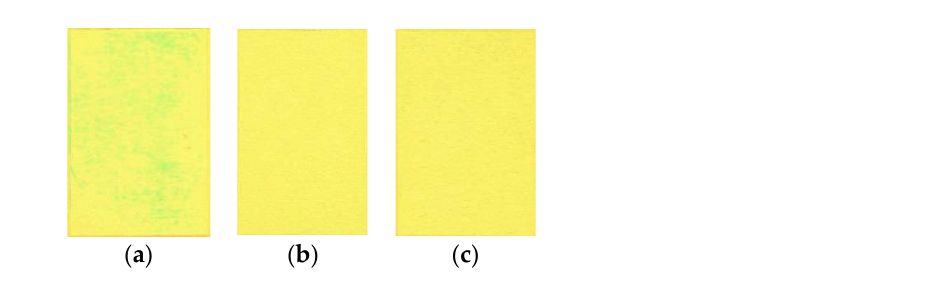
8 of 18 ( c ) Figure 10. RGB color channel histograms: ( a ) 1060, ( b ) 5052, ( c ) 6061. Specifically analyzing the differences between the R, B, and G color channels, the histograms show that in the R channel, the extreme values of 1060 and 6061 are both greater than 20,000, significantly higher than that of 5052, with 1060 slightly higher than 6061; in the B channel, the extreme values of 5052 and 6061 were both greater than 20,000, much greater than that of 1060, and the slopes of 5052 and 6061 were steeper while that of 1060 was relatively gentle; in the G channel, the extreme value of 1060 was larger than those of 5052 and 6061, and the extreme brightness of 1060 was near 75, while the extreme brightnesses of 5052 and 6061 were in the ranges of 110–114 and 124–126, respectively, with a clear demarcation line. From the histograms of R, G, and B color channels, it can be seen that 1060 could be